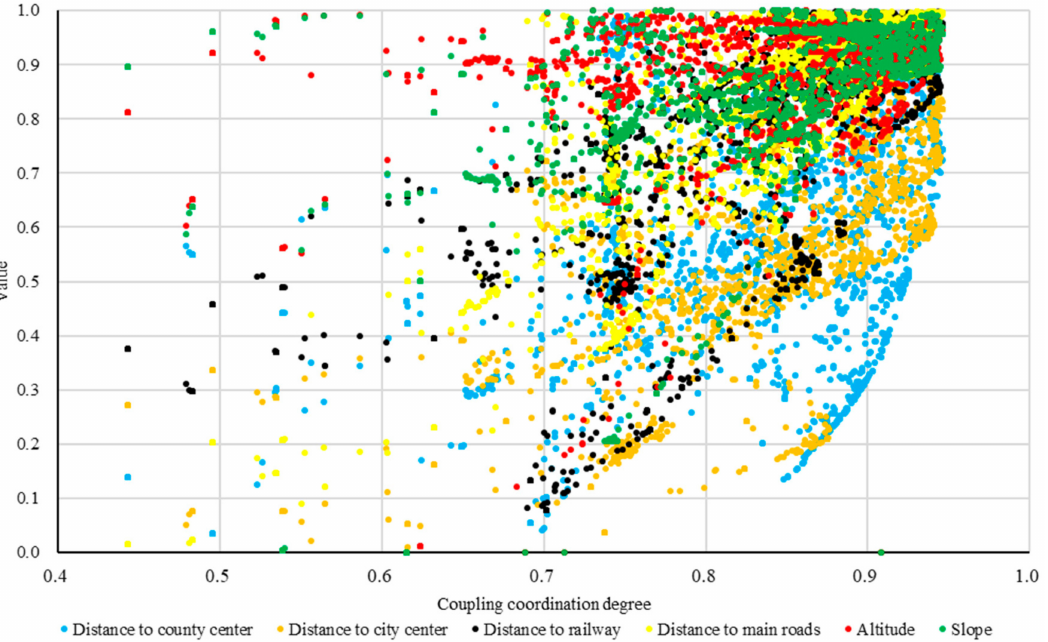
Figure 8. Correspondence between coupling coordination zones and location elements of rural